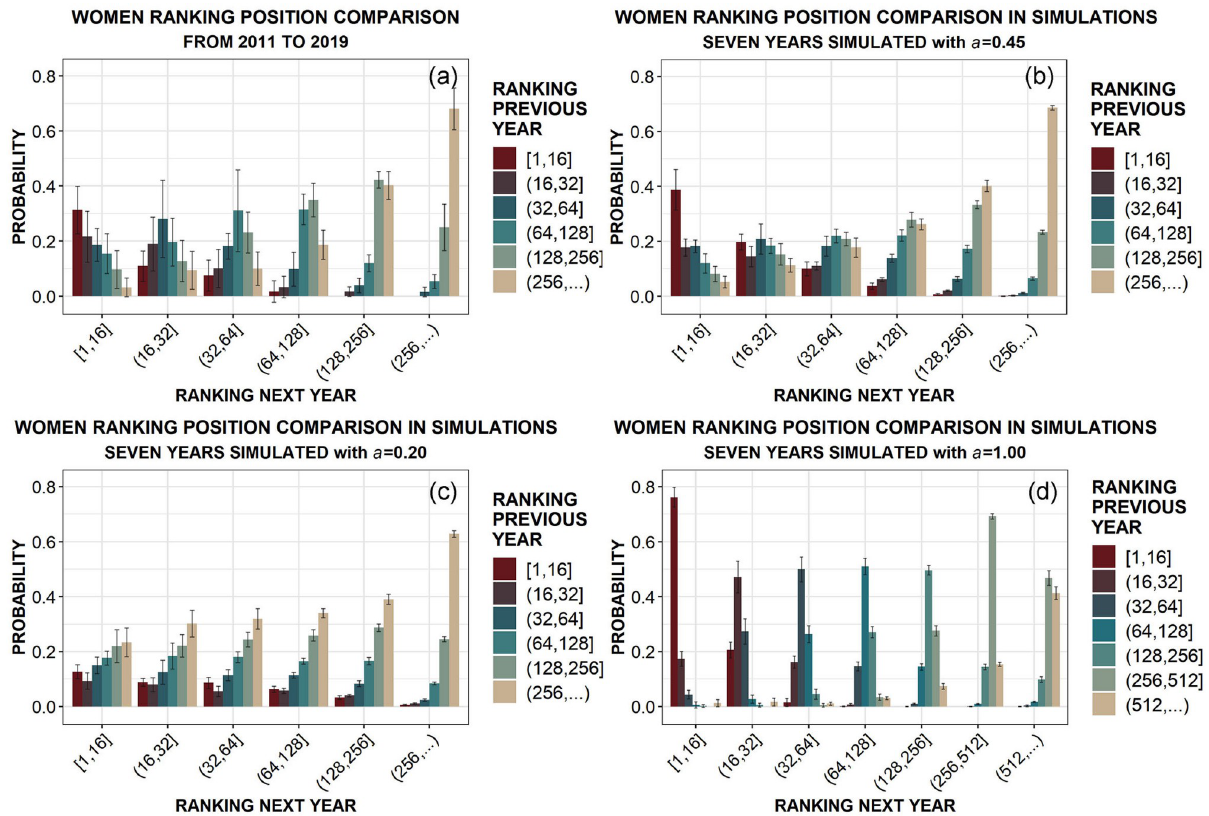
Fig 4. Comparison between data and simulations (averaged over 10 runs). Probability of having the same or a different placement the following year in Junior Women, given the associated ranking placement in the previous year. Ranking positions are organized in groups of different sizes, to enhance visualization. Sketch of the panels: (a) data; (b) simulation with the optimal value of a ; (c) simulation with a very low value of a ; (d) simulation with the highest possible value of a . For each mean outcome, the corresponding standard deviation is also reported as an error bar.